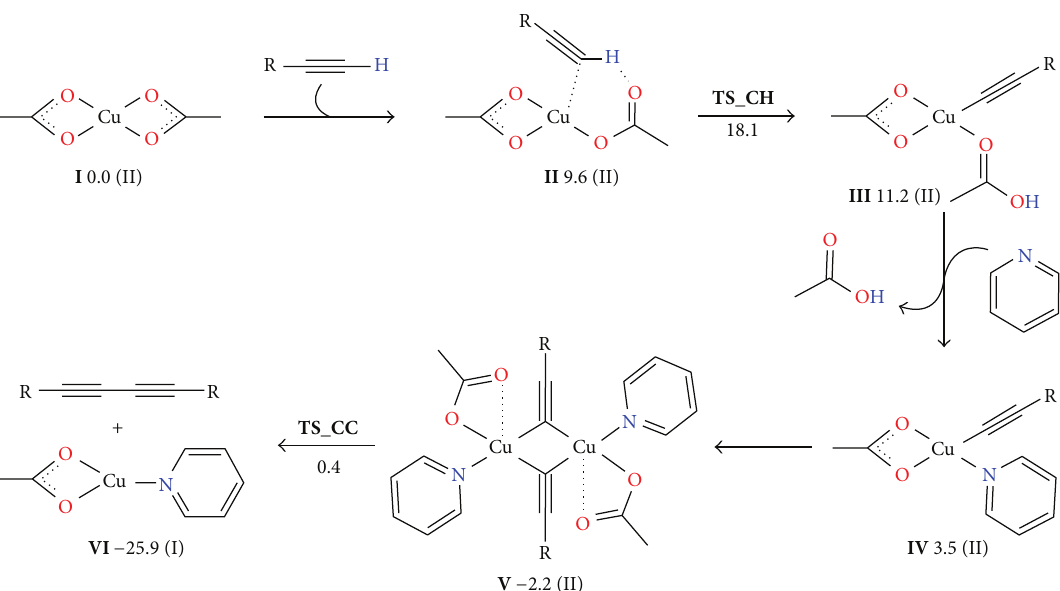
Scheme 4: Proposed catalytic cycle for the Eglinton reaction (free energies in kcal mol −1 ; the copper oxidation state is given between